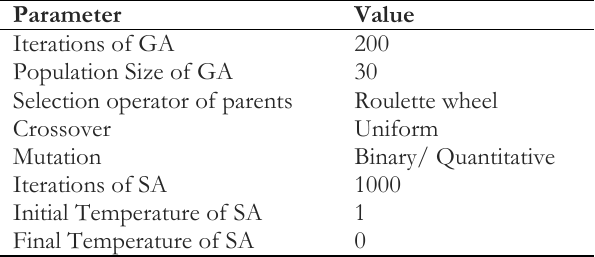
Table 5. Parameters of the GA-SA algorithm.